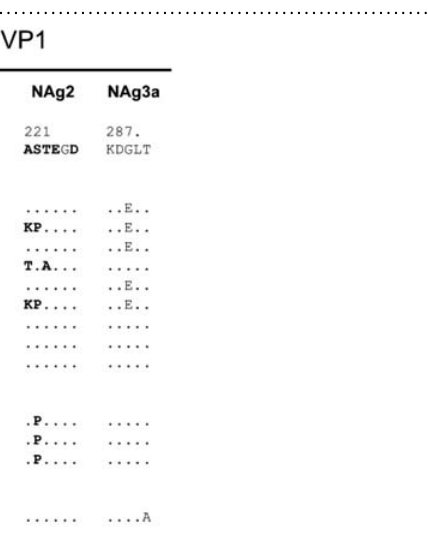
antibody titers below 1:8 against SD-98, 3 against SD-04 and 1 against both SD-99 and SD-04. In contrast, these 10 individuals were still protected against both vaccine strains. This group had GMTs against Sabin 2 and MEF of 69 and 53, respectively, and all individuals had protective titers (i.e. above 1:8). Thus 10/150 (7%) individuals . 21 years old who had protective neutralizing antibody titers against Sabin 2 and MEF had titers below the minimum protective level of 1:8 for at least one or more of the VDPV strains. The GMT against Group 1 isolate SD-05-1 was significantly lower than that against MEF (Table 3) in cohort F. GMT against MEF, Group 1 isolate SD-98, and Group 2 aVDPVs SD-06-1 and SD-06-02, were tested in cohorts G and H. Consistent with previous findings, the GMTs for Group 1 SD-98 were significantly lower (p , 0.05) then against MEF (Table 3). The GMTs for Group 2 isolates fell between those for MEF and SD- 98, however with the exception of SD-06-1 in cohort G, they were not significantly different from MEF.